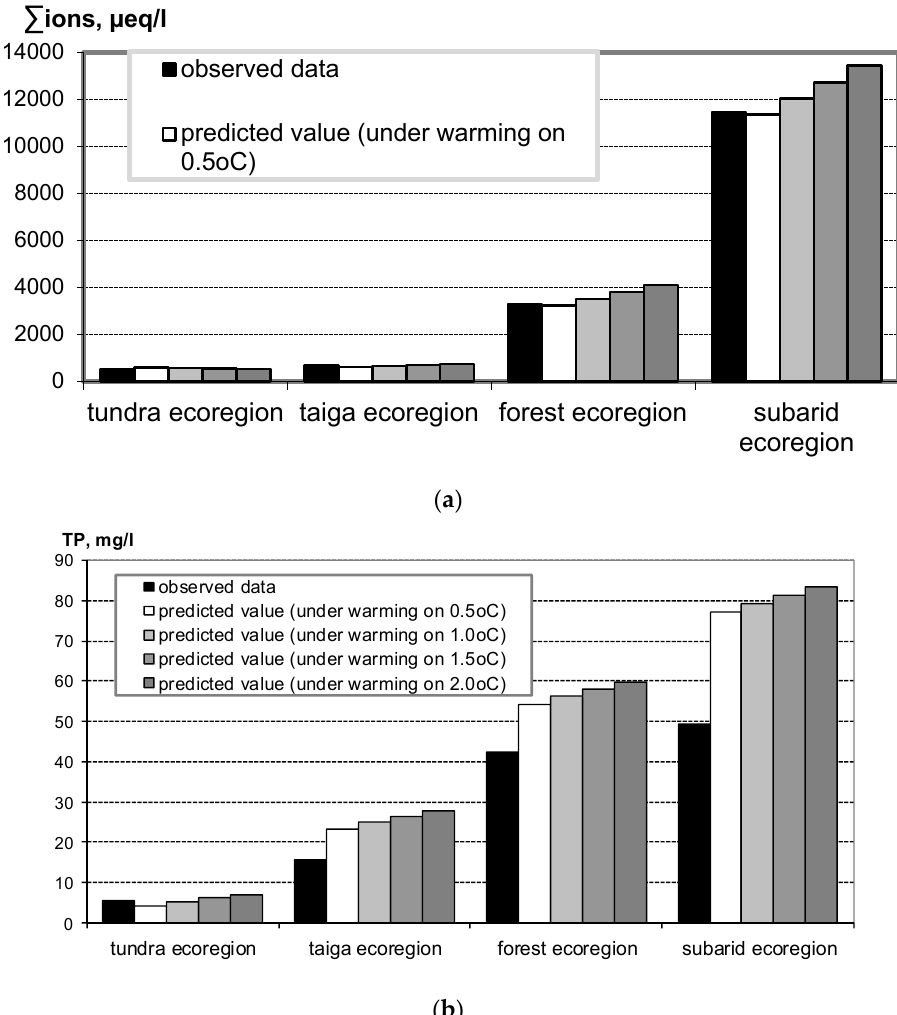
Figure 2. The observed and predicted values of sum ions ( a ) and total phosphorus ( b ) for the climatic ecoregions within European Russia along a climatic transect from northern tundra to the southern arid zone [11].